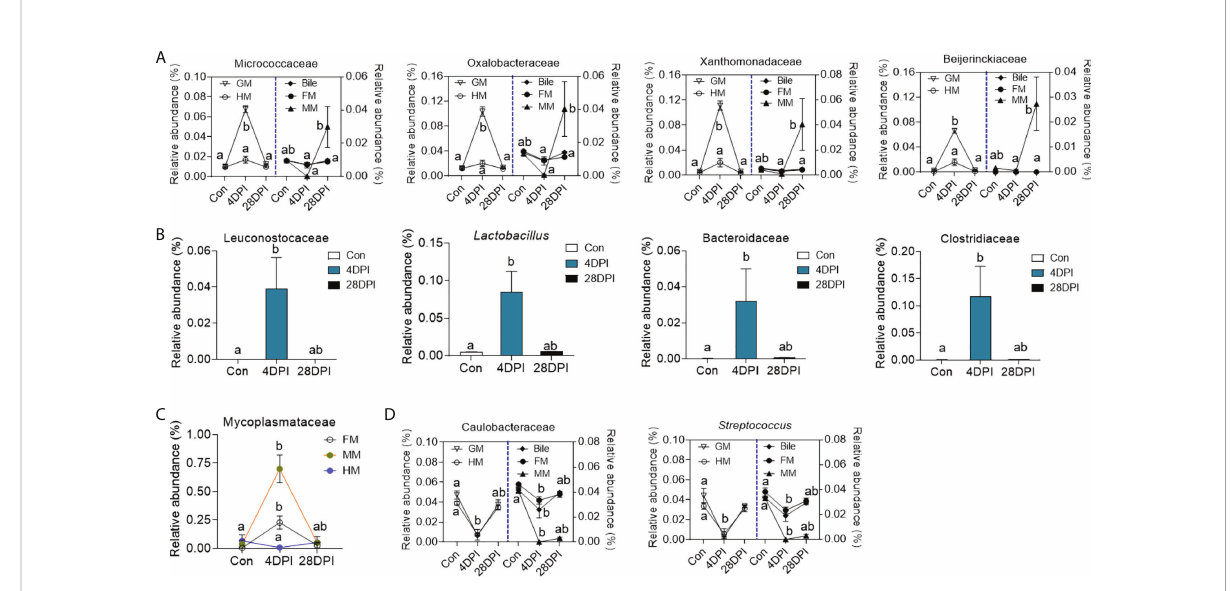
FIGURE 6 Dynamic alteration of microbial microbes in GM, bile and gut mucosa upon viral infection. (A) Line chart showing the representative abundance from top 50 bacterial families in GM, bile, FM, MM, and HM from control and IHNV-infected fi sh at 4 and 28 DPI ( n = 8 fi sh per group). Statistical differences were evaluated by Kruskal-Wallis test. (B) Histogram showing the representative abundance of bacterial taxa in bile from control and IHNV-infected fi sh at 4 and 28 DPI ( n = 8 fi sh per group). Statistical differences were evaluated by Kruskal-Wallis test. (C) Line chart showing the representative abundance of Mycoplasmataceae family in FM, MM, and HM from control and IHNV-infected fi sh at 4 and 28 DPI ( n = 8 fi sh per group). Statistical differences were evaluated by Kruskal-Wallis test. (D) Line chart showing the representative abundance of bacterial taxa in GM, bile, FM, MM, and HM from control and IHNV-infected fi sh at 4 and 28 DPI ( n = 8 fi sh per group). Statistical differences were evaluated by Kruskal-Wallis test. Data are representative of two independent experiments (mean ± SEM). The different lowercase letter represent signi fi cant difference ( p < 0.05) exist in these groups within each